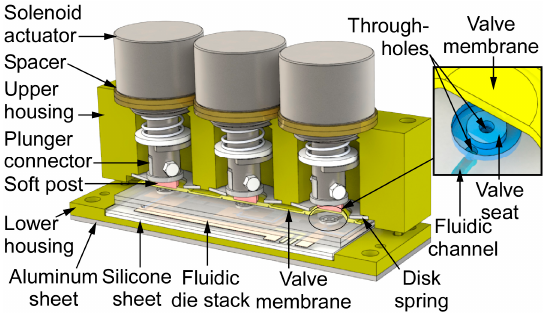
Figure 2. The architecture of the microvalve module. The microvalve on the right is in the open state, whereas the other two of the microvalves are in the closed state.